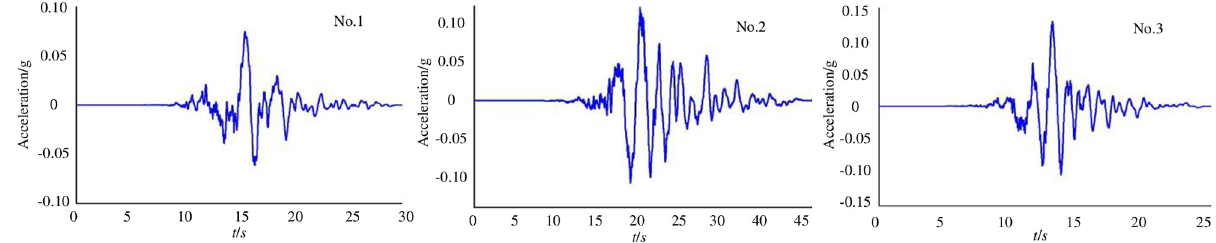
Fig 3. Acceleration time history curves of the No.1-No.3 ground-motion records.